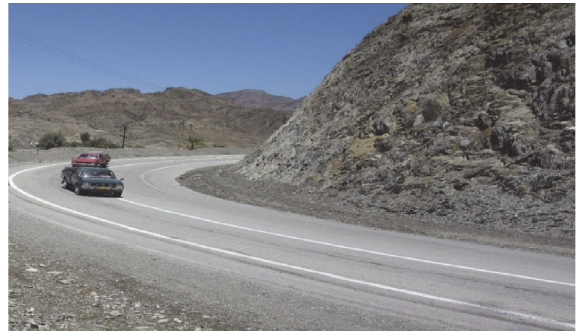
Figure 2: Section 4: Bepaataan.